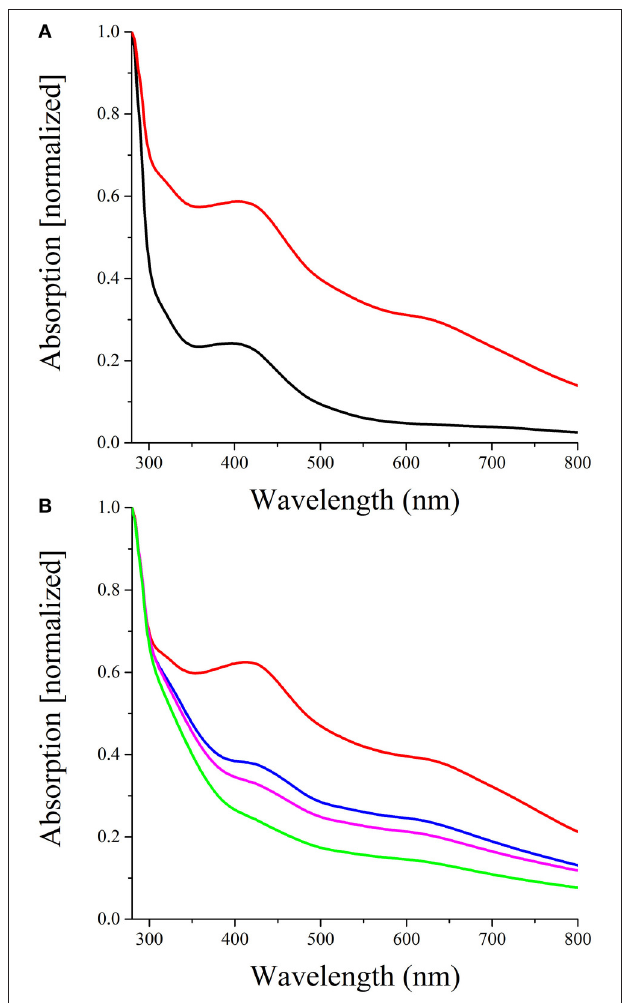
FIGURE 3 | FnrL contains an oxygen labile Fe-S cluster (A) Reconstitution of the D. shibae DFL12 T FnrL Fe-S clusters. The spectrum of 40 µ M FnrL (black line) and 20 µ M Fe-S cluster reconstituted FnrL (red line) are shown. Samples were normalized by setting absorption at 280nm to 1. (B) Oxygen lability of the FnrL Fe-S cluster. The exposure of Fe-S cluster reconstituted FnrL to air resulted in a decrease of absorption at 420nm over time [0min (red line), 60min (blue line), 120min (magenta line), and 240 min (green line)].